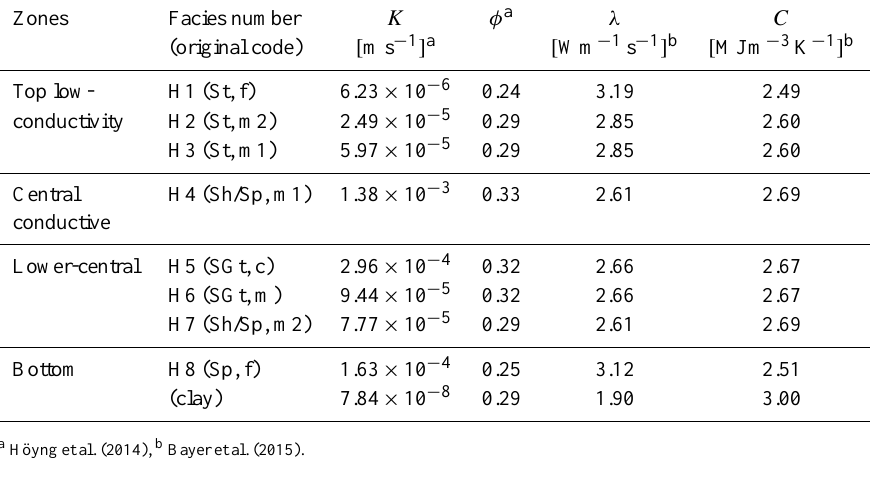
Table 1. Hydraulic conductivity, K ; porosity, φ ; thermal conductivity, λ ; and bulk heat capacity, C ; for the nine facies that build up the Descalvado analog. The four zones are introduced for discussion of results and listed here with the major facies components.